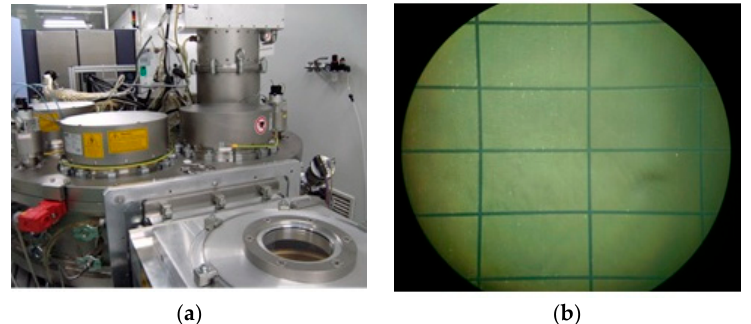
Figure 6. The key manufacturing process ( a ), Inductively coupled plasma (ICP) deep silicon etching; ( b ) Laser cutting.